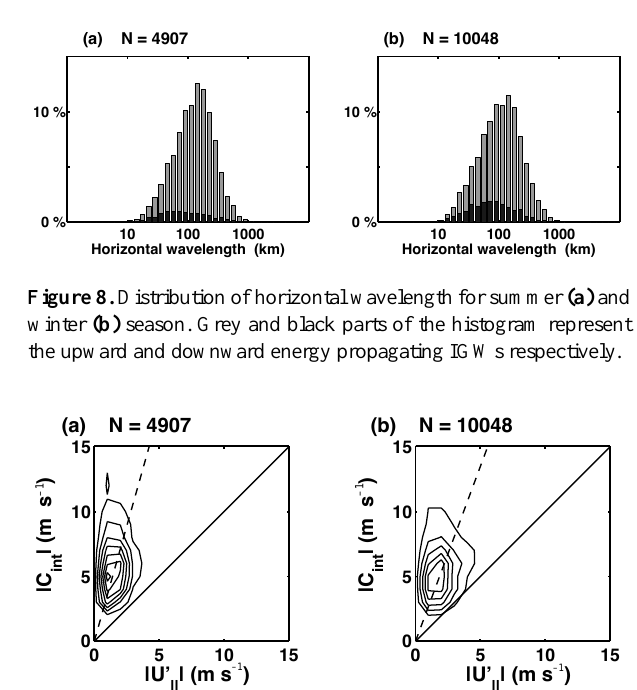
Figure 9. Distribution of intrinsic phase velocity ( C int ) and pertur- bation velocity parallel to the horizontal wavenumber vector ( U (cid:48) || ) of IGWs for summer (a) and winter (b) . The step of lines is 1 and the unit is